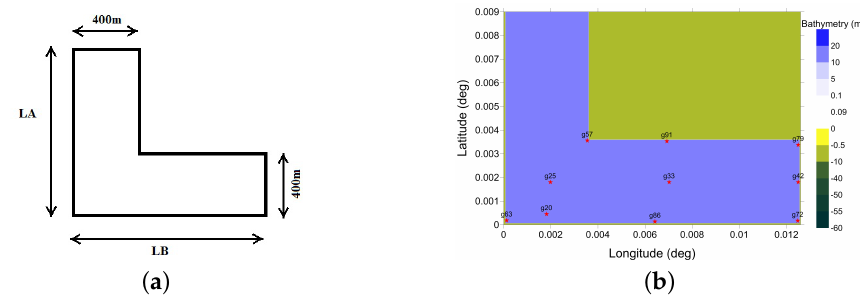
Figure 1. L-type basin used in the simulations. ( a ) LA is the vertical dimension and LB the horizontal dimension of the L-type basin. ( b ) Dimensions are in the geographical outline. Red stars represent the gauge